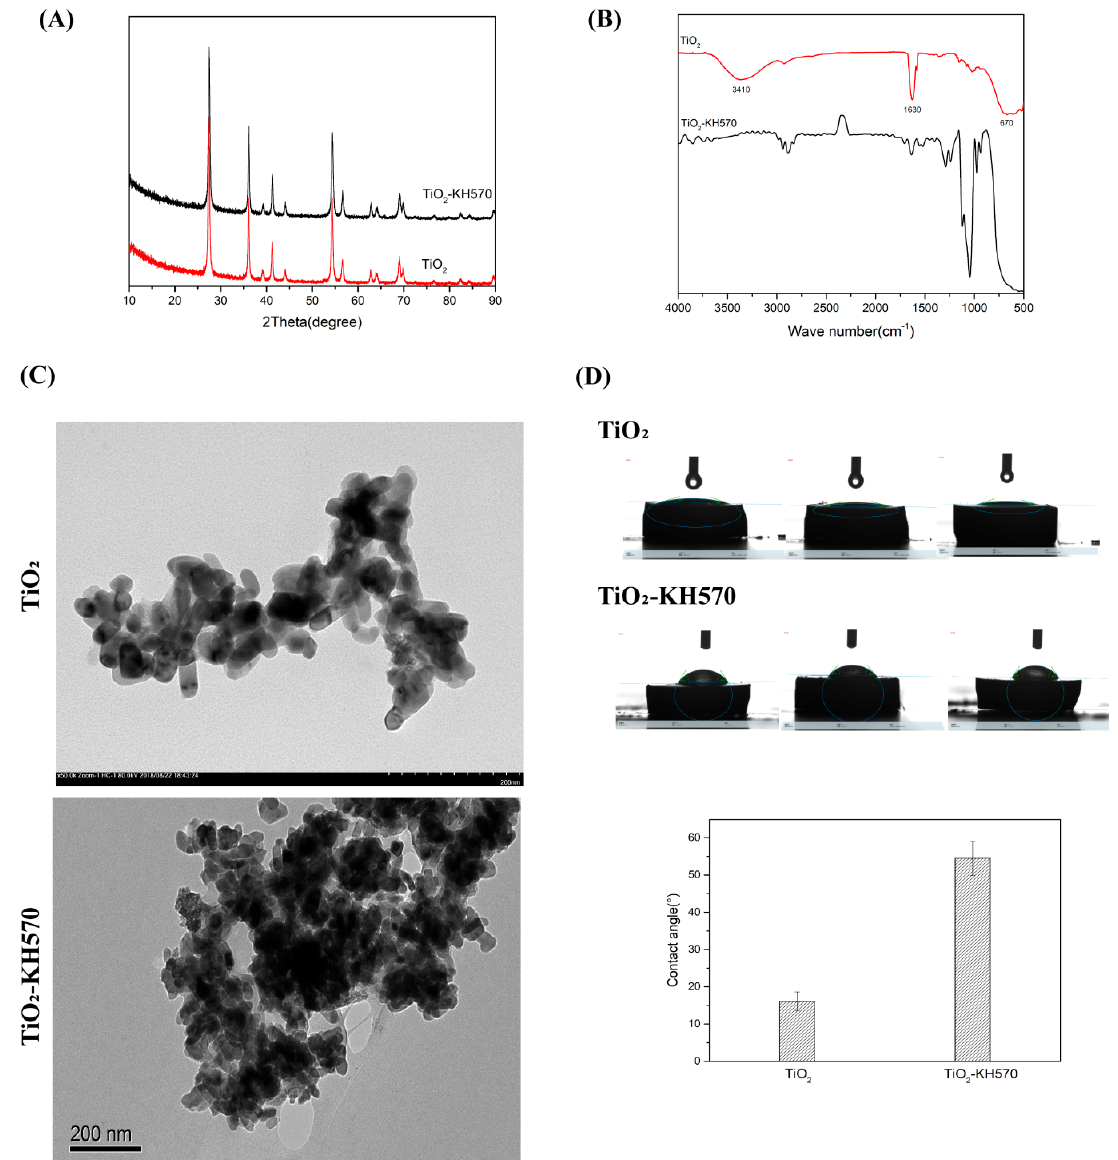
Figure 1. Characterizations of prepared NPs of TiO 2 and TiO 2 –KH570 by the use of XRD ( A ), FTIR ( B ), TEM ( C ), and contact angle test ( D ).